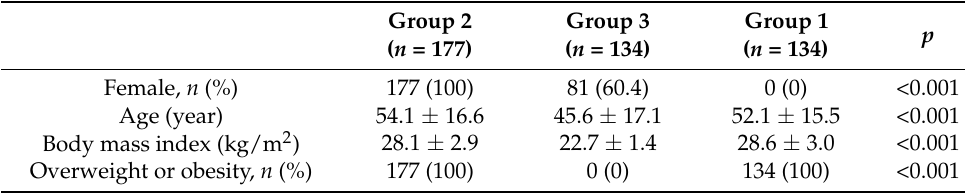
Table 4. Cluster analysis to identify participants at risk for weight gain during